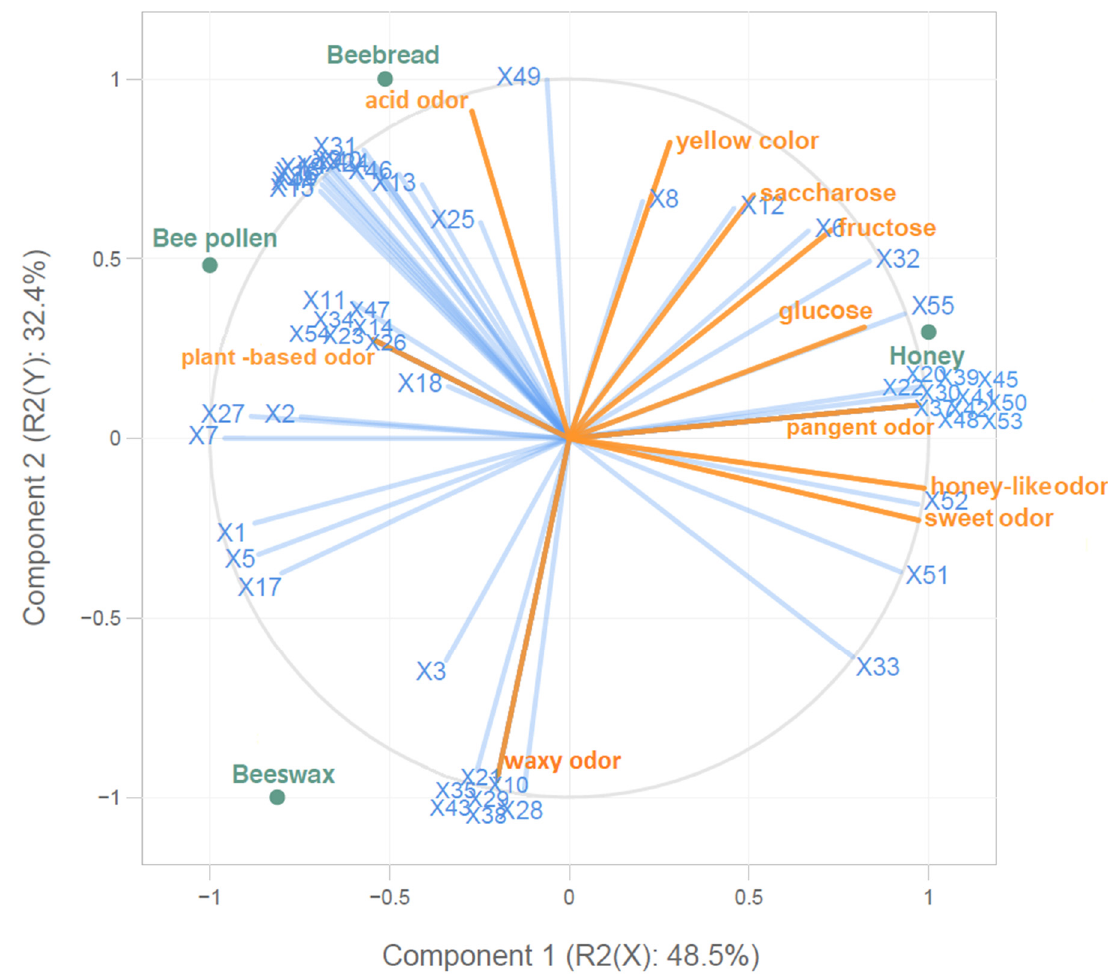
Figure 3. PLS correlation analysis of samples, between aroma compounds and sensory attributes; X1–X55 represent the number of compounds identified in the bee products (Table